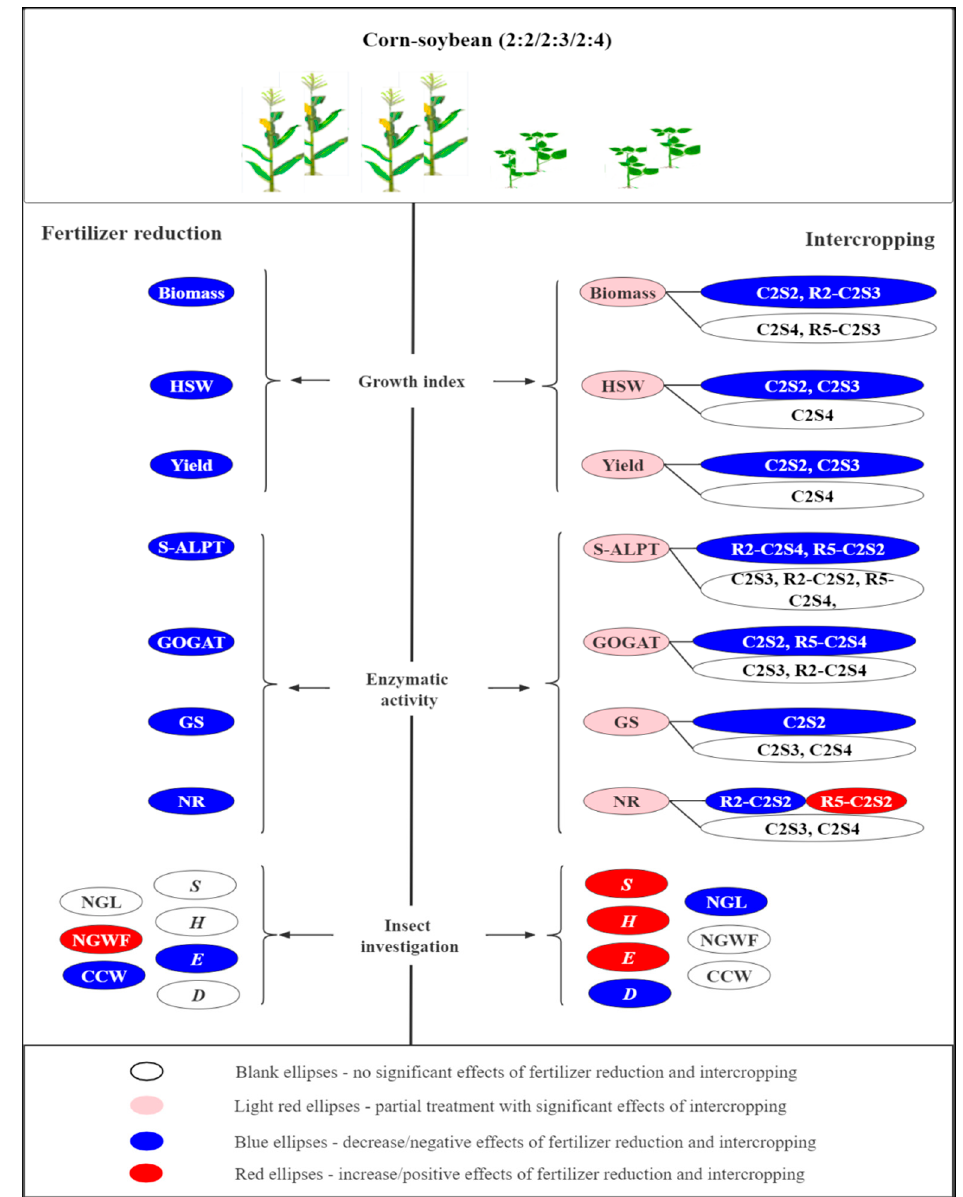
Figure 6. Patterns of intercropping planting pattern and fertilizer levels affecting soybean yield-related traits, enzymatic activity and insect communities (Note: HSW: 100-seed weight; R2/5: R2/5 growth stage; S: sole-crop soybean; C2S2, C2S3 and C2S4: intercropping of two corn rows with two, three and four rows of soybean, respectively; SALPT: soil alkaline protease; GOGAT: glutamine oxoglutarate aminotransferase; GS: glutamate synthetase; NR: nitrate reductase; S : species number; H : Shannon–Wiener diversity index; E: Pielou evenness index; D: Simpson dominance index; NGL: number of green leafhoppers; NGWF: number of greenhouse whiteflies; CCW: common cutworm. The growth stage was added before the intercropping mode to indicate that it was significant only during this growth stage, and the absence of the growth stage indicates that it was significant in both the R2 and R5 stages).